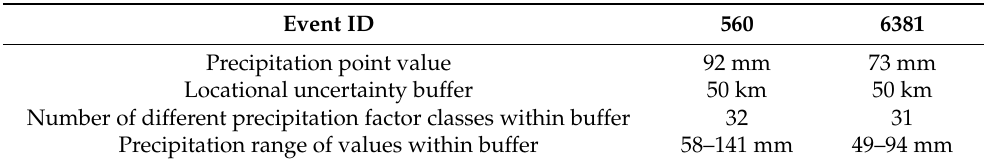
Table 4. Impact of location uncertainty: buffered area values vs. point value of precipitation factor class, for two sample events, 560 and